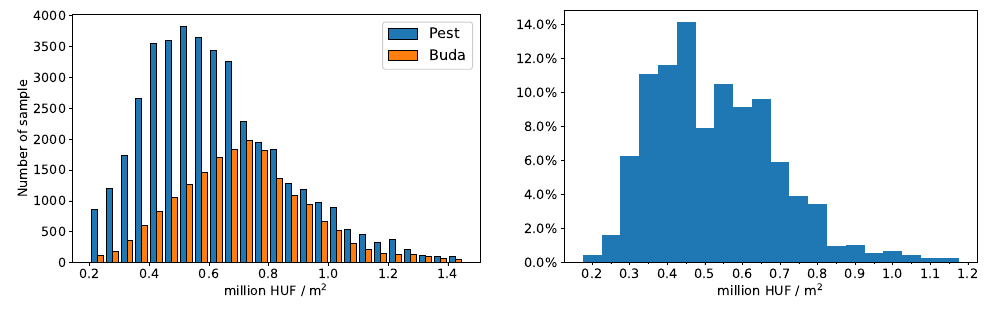
Figure 9. Distributions of the estate price: ( a ) shows the distribution of the estate price samples distinguished by the Buda and Pest of the city, and ( b ) shows the distribution of the home location prices of the individuals.